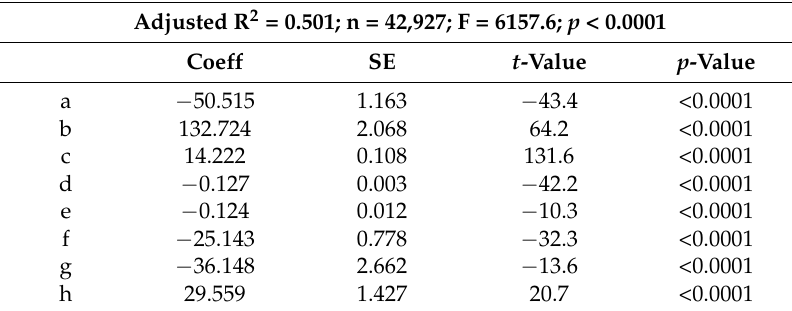
Table 5. Regression model for predicting net grapple yarder productivity as a function of significant independent